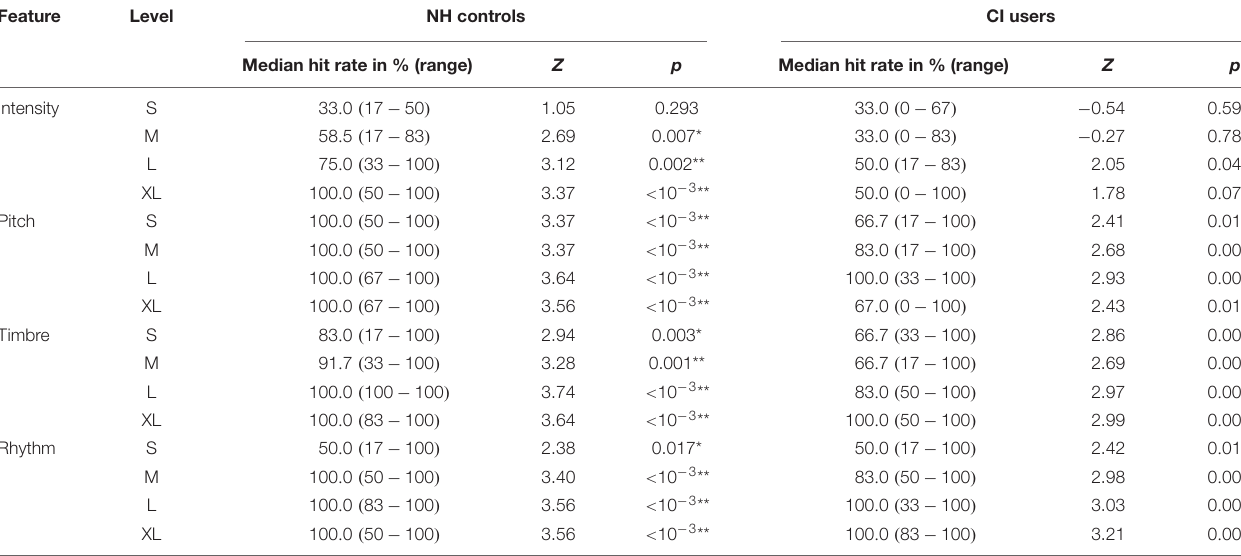
TABLE 5 | Behavioral hit